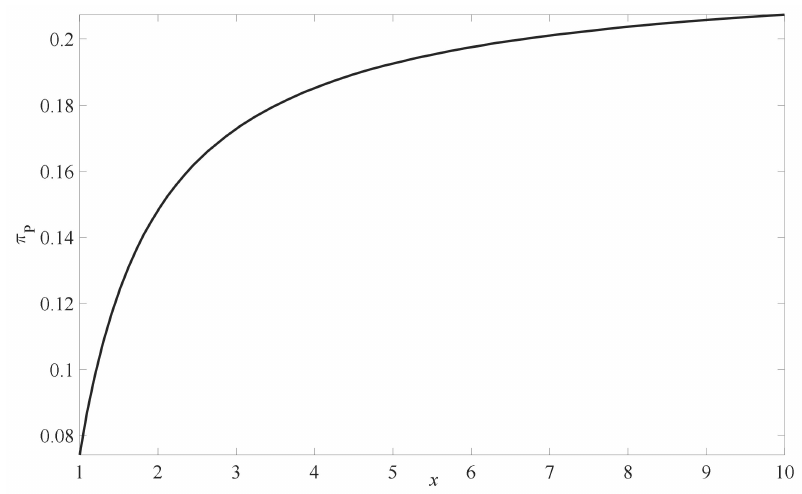
Figure 4. Platform revenue changes as consumer data usage level x under strategy π p ( 1,1 )